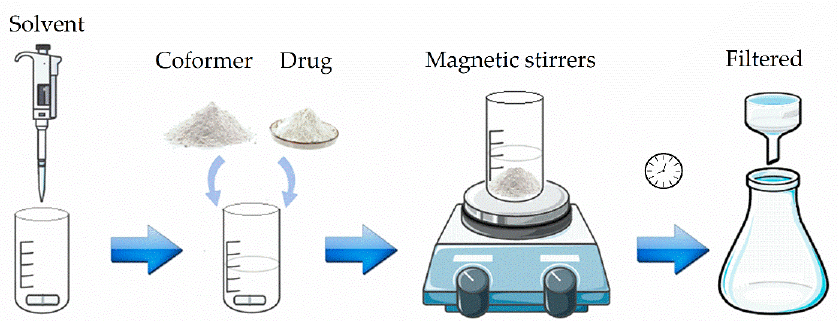
Figure 1. Illustration of cocrystal production by the RCM. First, the solvent is added, then the coformer and the drug. The reaction is kept under magnetic stirring for approximately 48 h and then filtered.